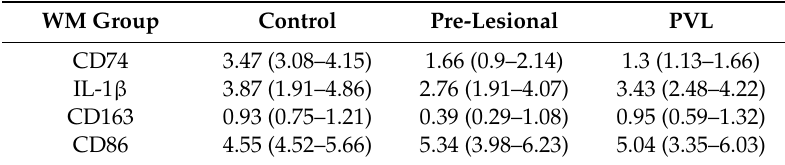
Table 7. Expression of CD74, IL-1 β , CD163 and CD86 in ageing periventricular white matter. The percentage area of immunoreactivity of each of the markers is shown, median (IQR).